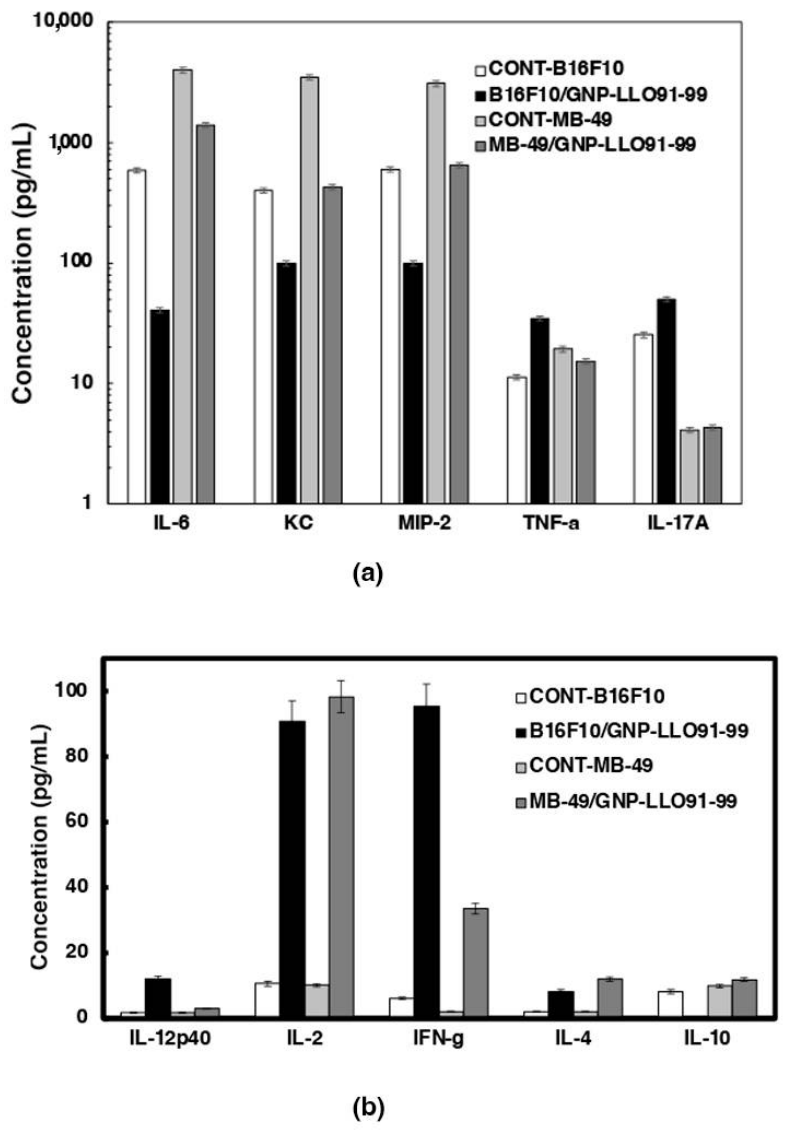
Figure 4. GNP-LLO 91–99 nanovaccines activate Th1 responses in mice models of melanoma and BC. Cytokines were measured in sera of mice transplanted with melanoma or BC and treated with GNP-LLO 91–99 nanovaccines (melanoma: white, BC: light gray bars) or untreated (melanoma: black, BC: dark gray bars) using a multiparametric Luminex kit (Milliplex MAP Mouse High Sensitivity T Cell Magnetic Bead Panel, EMD Millipore Corporation, Billerica MA) following the manufacturer’s instructions. Cytokine concentrations are expressed as the average of three replicates in pg/mL ±